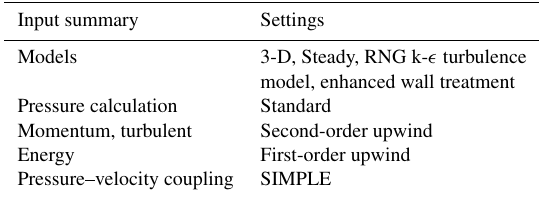
Table A1. Summary of CFD model